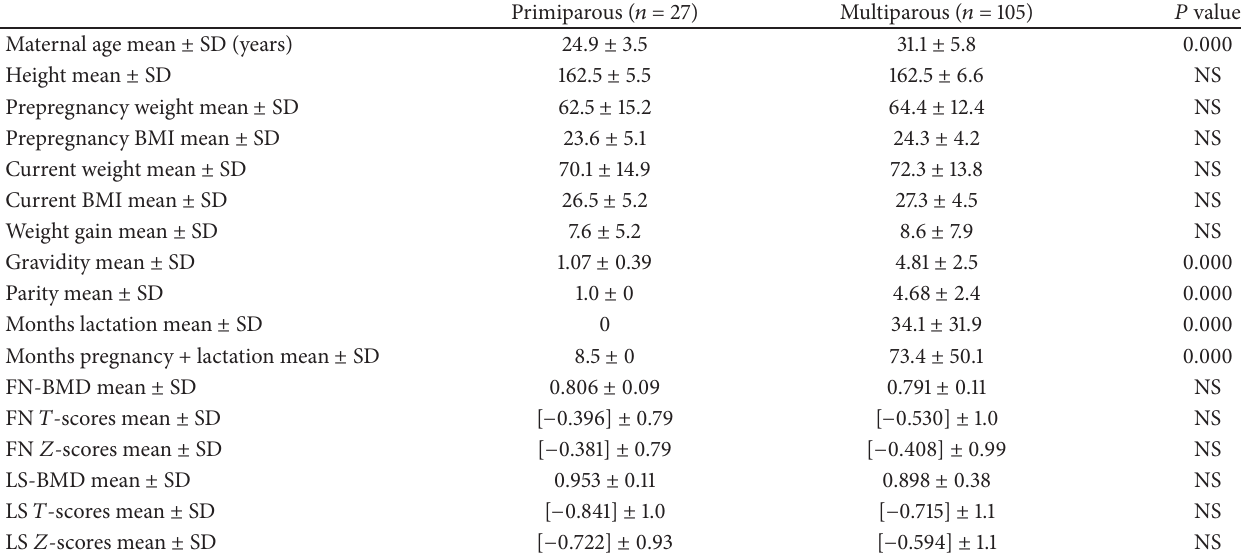
Table 3: Comparison of bone density variables among primiparous women to the multiparous ( ≥ 2 births) women; significance based on Levene’s test for Equality of